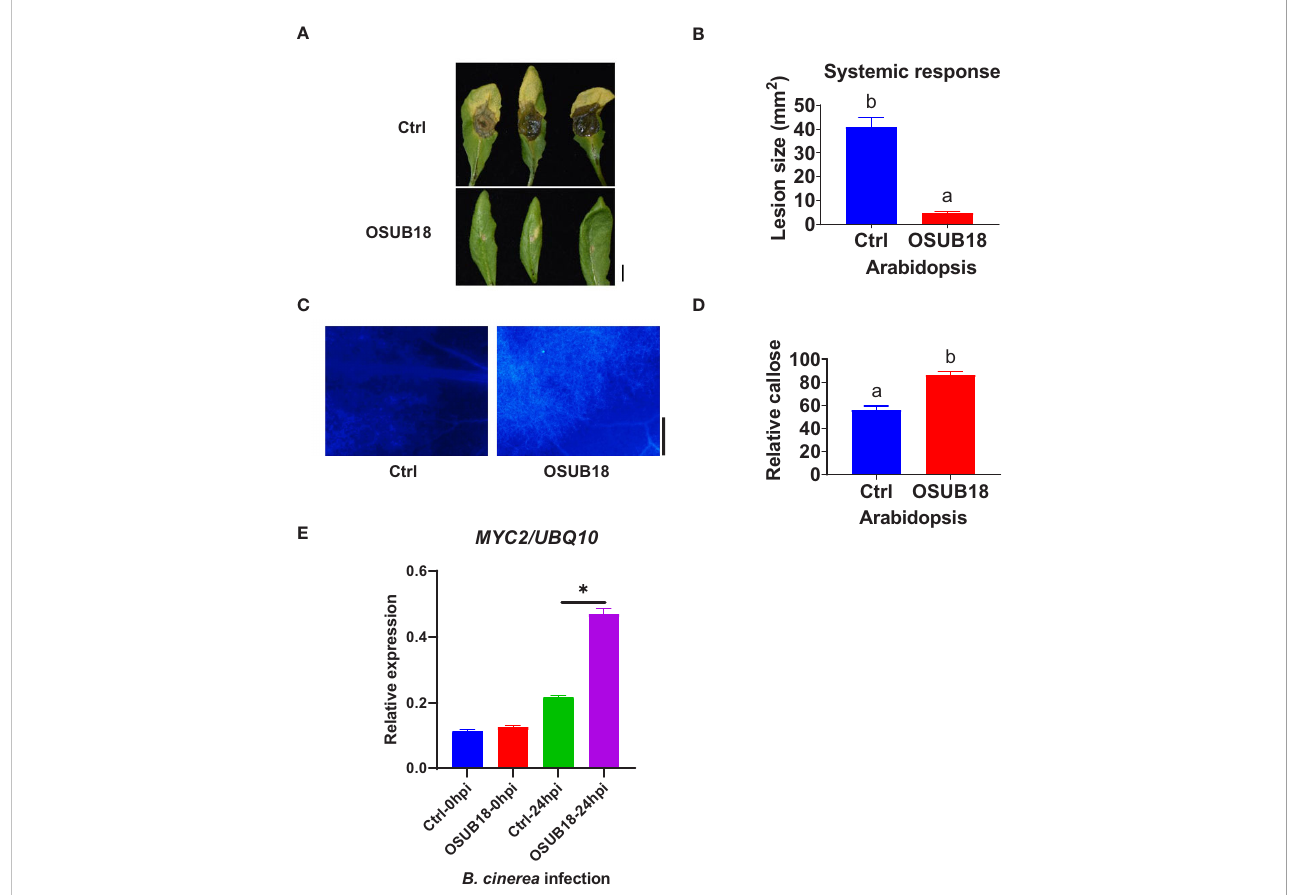
FIGURE 5 OSUB18 root drench treatment triggered strong ISR in A thaliana against the attack of the fungal pathogen B cinerea via signi fi cantly more callose deposition and higher MYC2 gene expression. (A) OSUB18 root drench treatment increased host plant defense of Col-0 plants against B cinerea infection. Scale bar = 5 mm. (B) Quanti fi cation of the disease symptoms in (A) . (C) Col-0 plants drenched with OSUB18 deposited signi fi cantly more callose upon the B cinerea infection (24hpi), as illustrated by the aniline blue-staining assay. Scale bar = 500 µm. (D) Quanti fi cation of the callose deposition in (C) . (E) The relative expression level of the ISR-responsive gene MYC2 . Water or OSUB18-drenched plants were inoculated with B cinerea spores. 0 or 24 hours later, the inoculated leaves were collected for the qRT-PCR assay. The UBQ10 gene was used as an internal reference in the qRT- PCR assay. Data present mean ± SE of three biological replicates. Data with different letters or * indicate a p- value < 0.05 on Student ’ s